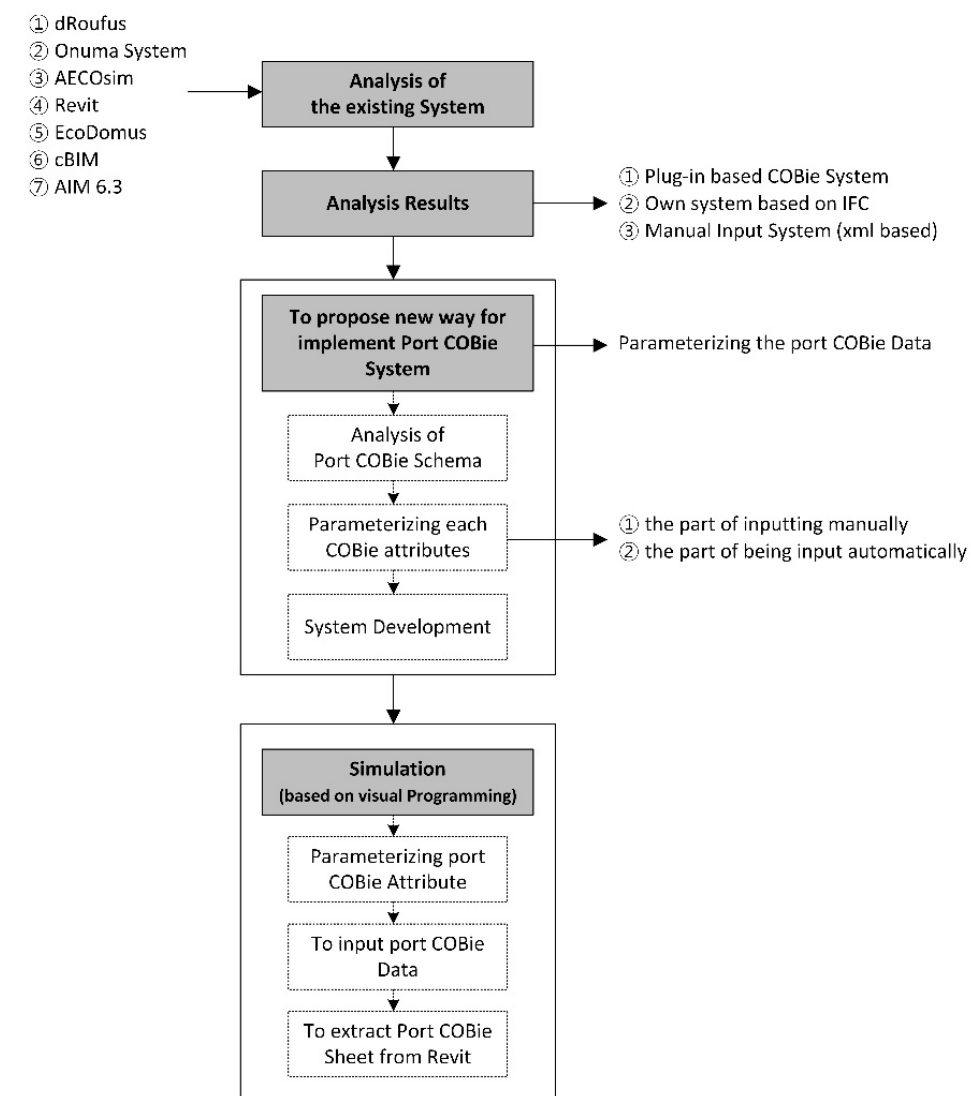
Figure 9. Research methodology for implementing the port COBie System.